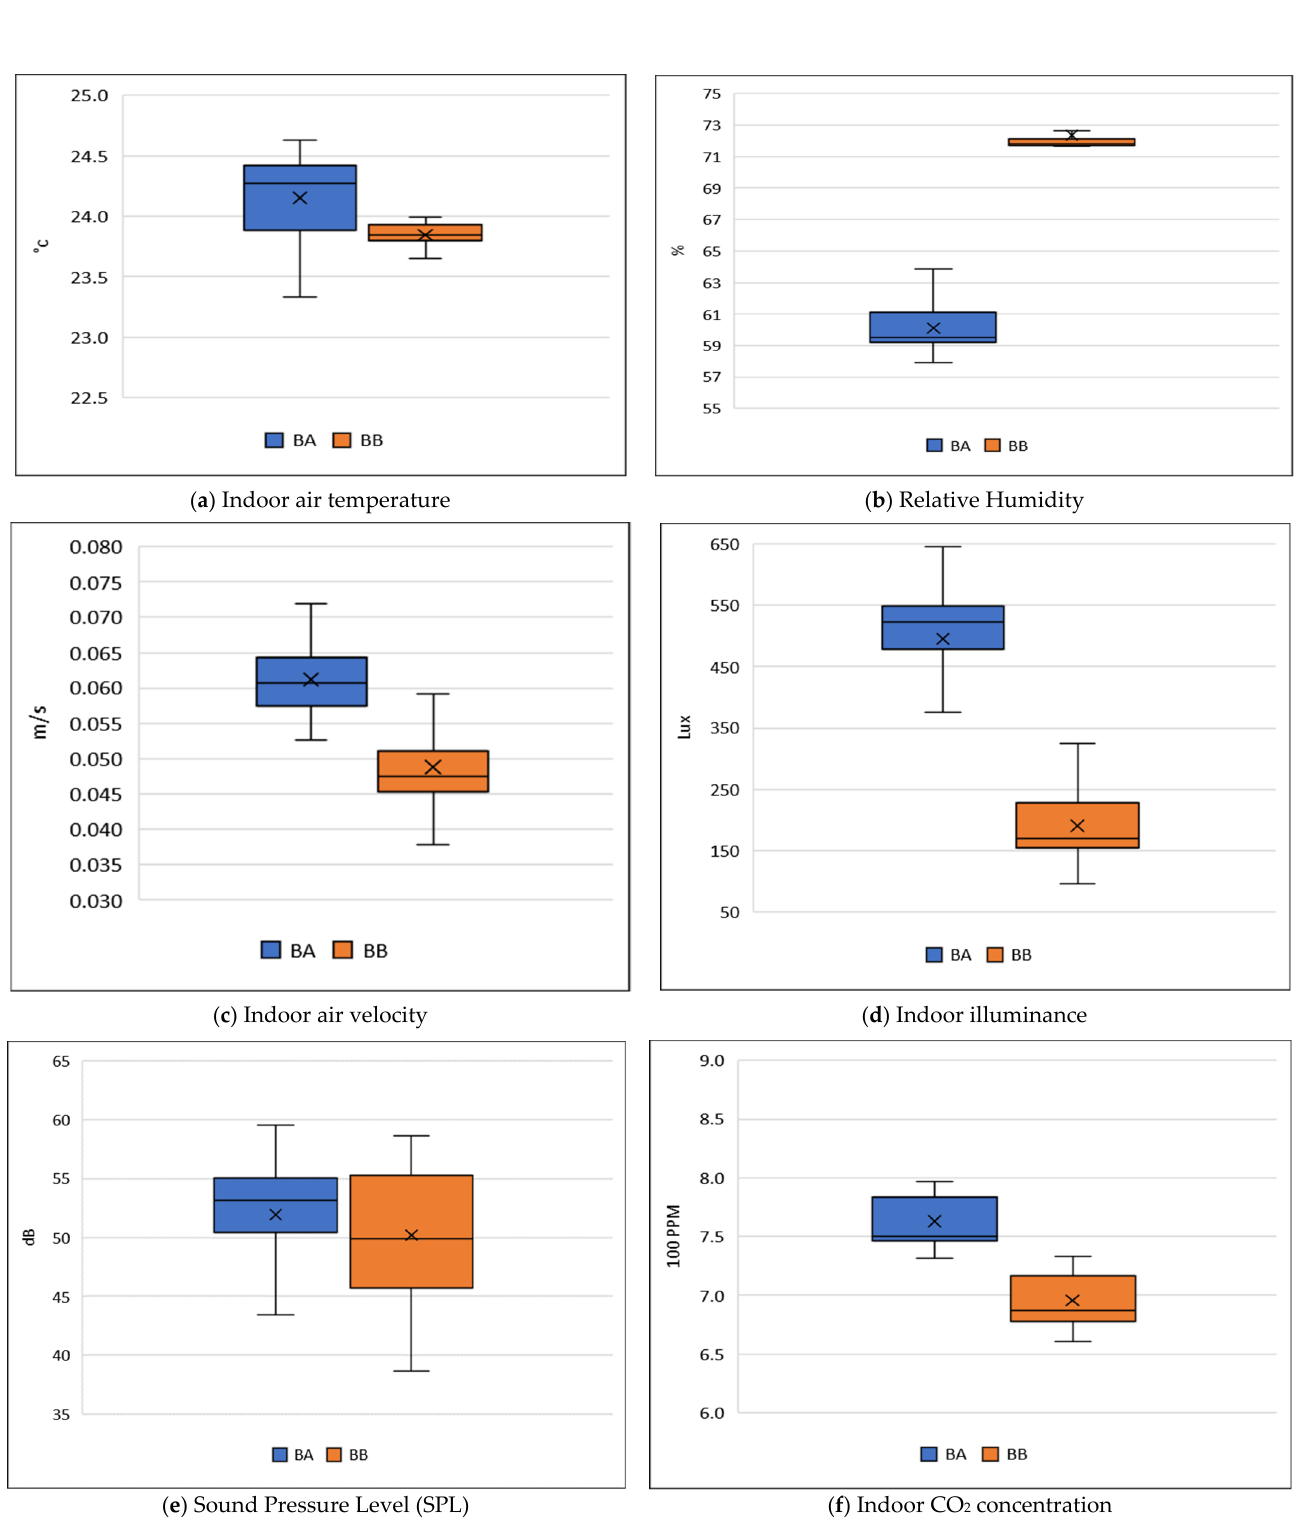
Figure 3. Distribution of IEQ parameters for building A (BA) and building B (BB).